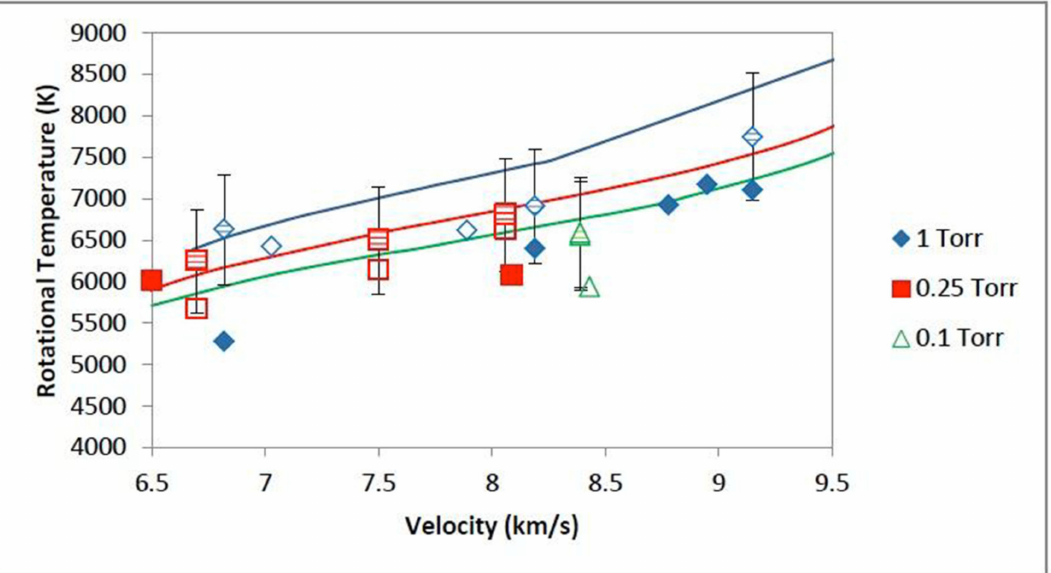
Figure 8. Rotational temperature for CN and C2 systems (from